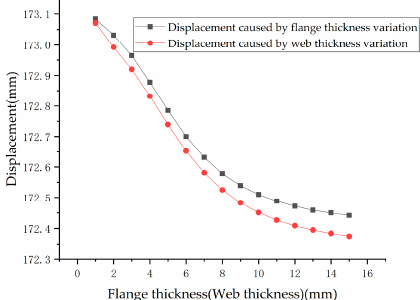
Figure 4. Sensitivity curve of B S plate thickness.